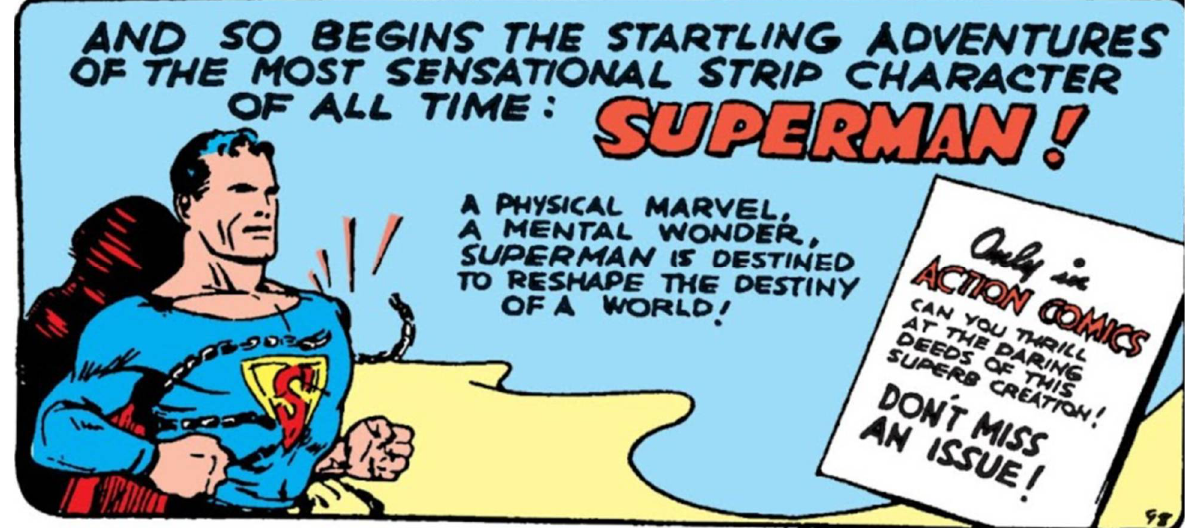
Figure 15. Joe Shuster, Closing Panel: “And So Begins the Startling Adventures of the Most Sensational Strip Character of all Time: Superman!” (panel No. 98), 1938. Siegel and Shuster (June 1938), “Superman”, Action Comics #1 (Siegel and Shuster 1938a, p. 20). © DC Comics.